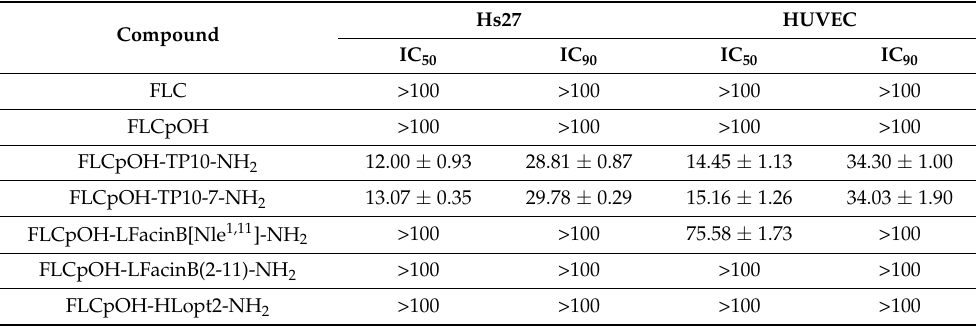
Table 3. In vitro cytotoxicity (IC 50 and IC 90 ± SEM ( µ M)) of the FLC conjugates and their constituents toward Hs27 and HUVEC